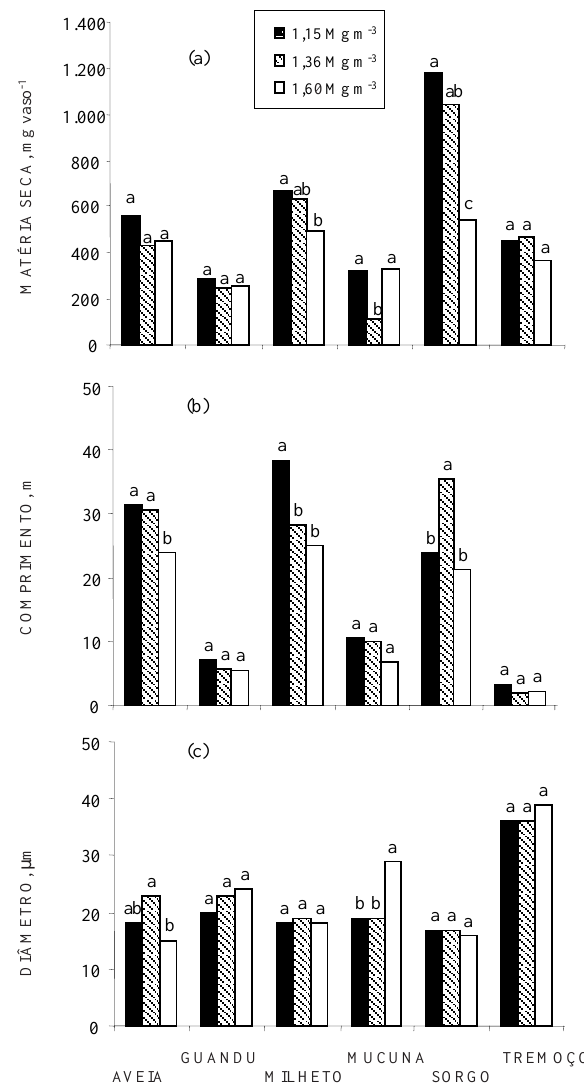
Figura 1. Produção de matéria seca (a), comprimento (b) e diâmetro (c) das raízes na profundidade de 0-15 cm, considerando as densidades do solo impostas na profundidade de 15-18,5